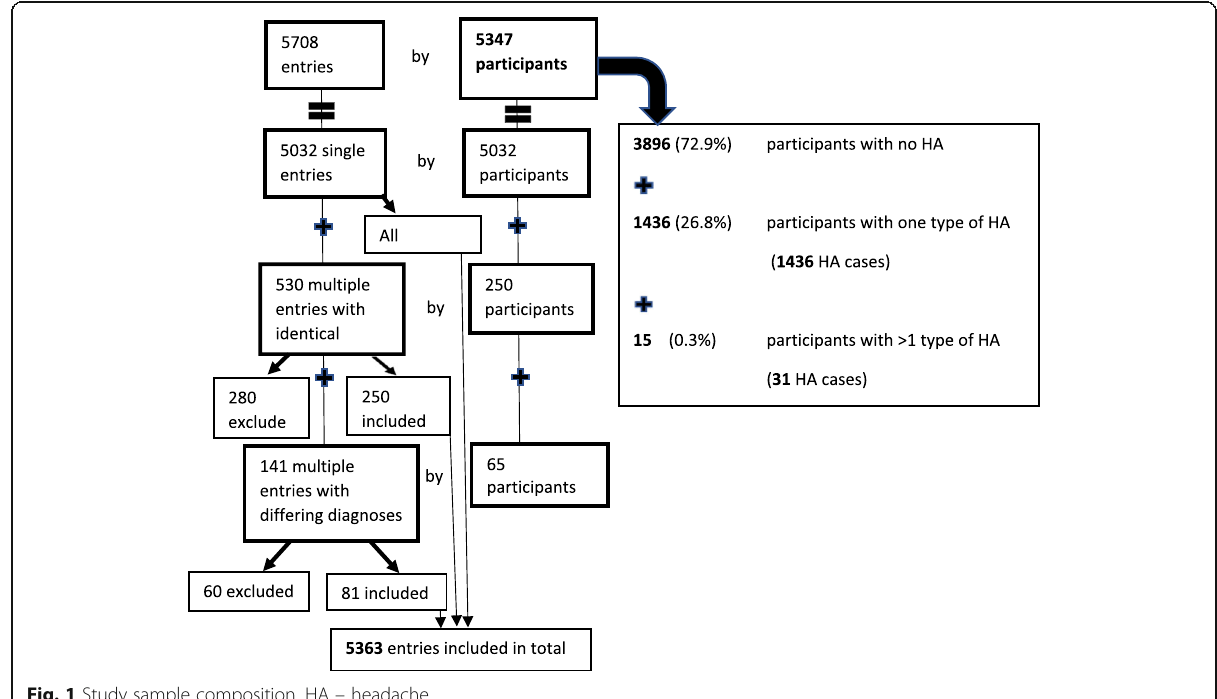
Fig. 1 Study sample composition. HA – headache